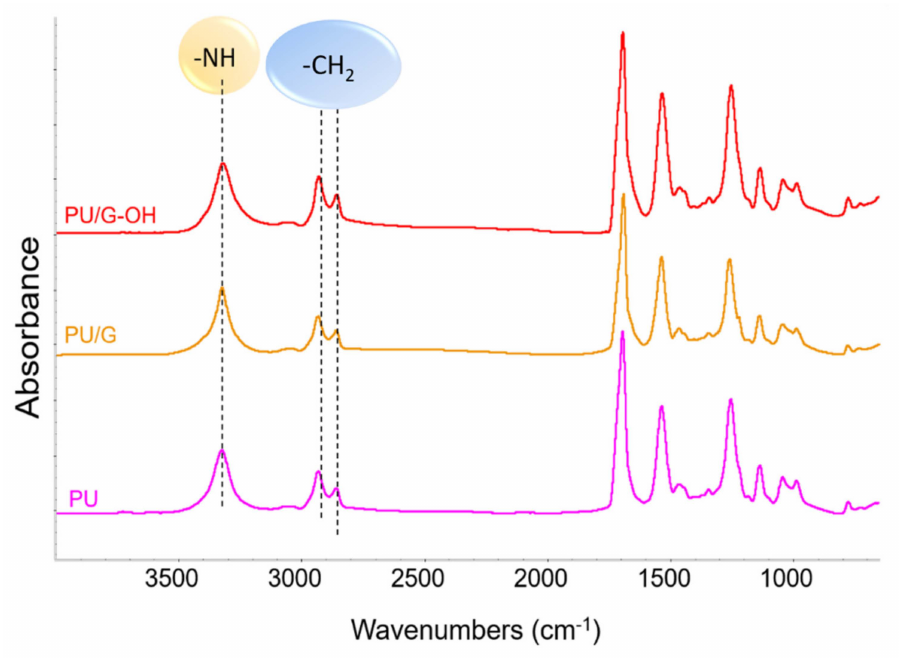
Figure 5. FTIR spectra of PU, PU/G, and